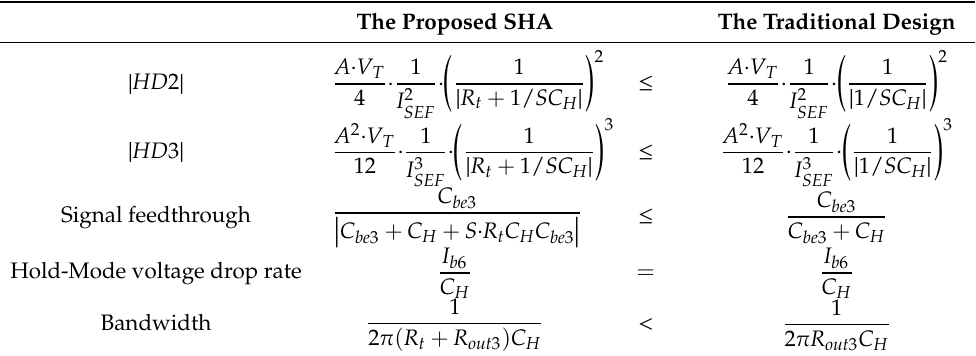
Table 1. Properties of the proposed SHA and traditional design.